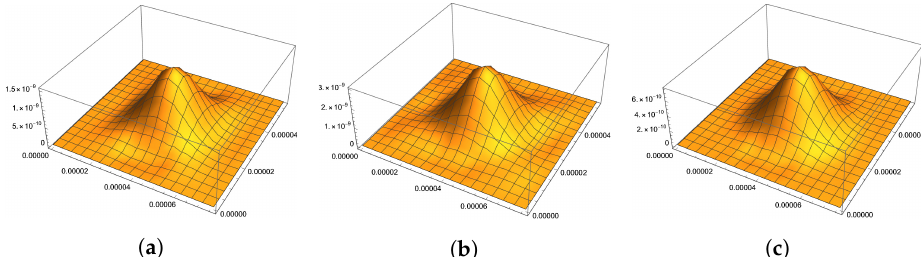
Figure 15. Influence of the density. ( a ) Recovered load. Mass per unit area ρ 0 = 4.444 × 10 − 3 kg/m 2 . Relative error Error R = 0.09. ( b ) Recovered load. Mass per unit area 0.2 ρ 0 . Relative error Error R = 0.013. ( c ) Recovered load. Mass per unit area 0.5 ρ 0 . Relative error Error R = 0.04.